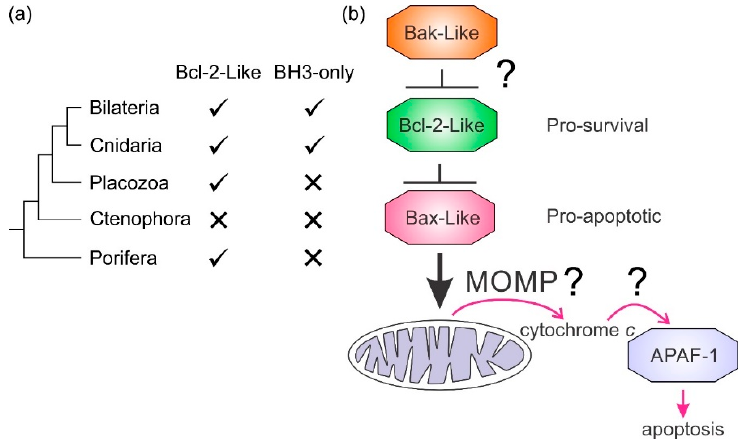
Figure 4. Bcl-2-like proteins in basal metazoan clades and potential apoptosis model. ( a ) Metazoan phylogenetic relationships and the presence or absence of Bcl-2 proteins. The presence or absence of Bcl-2 family members is indicated. ( b ) A simple model for intrinsic apoptosis in Porifera and Placozoa where BH3-only proteins have not been identified. Experiments have yet to delineate the roles of MOMP and adaptor protein initiation of caspases in their entirety.